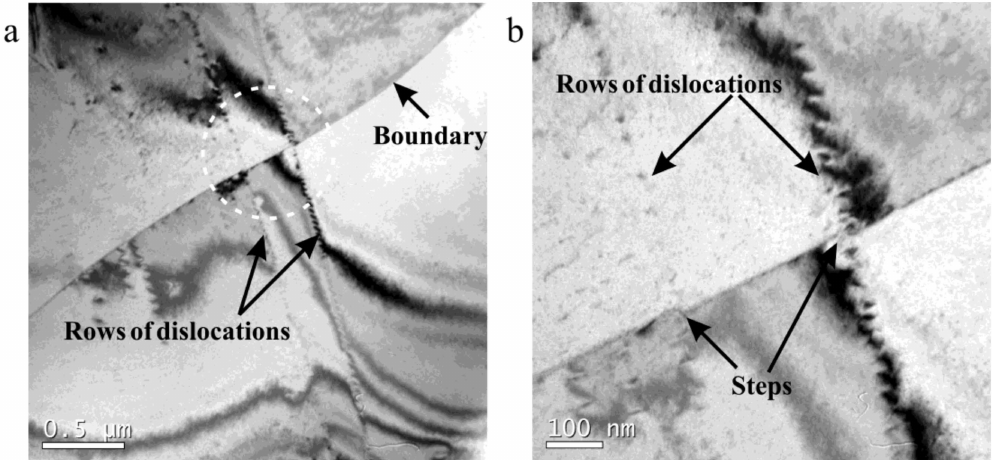
Figure 13. Dislocation morphology in 18Mn18Cr0.6N compressed at a cooling rate of 0.025 Ks − 1 to a strain of 0.4: ( b ) is a higher magnification of the marked circle region in ( a